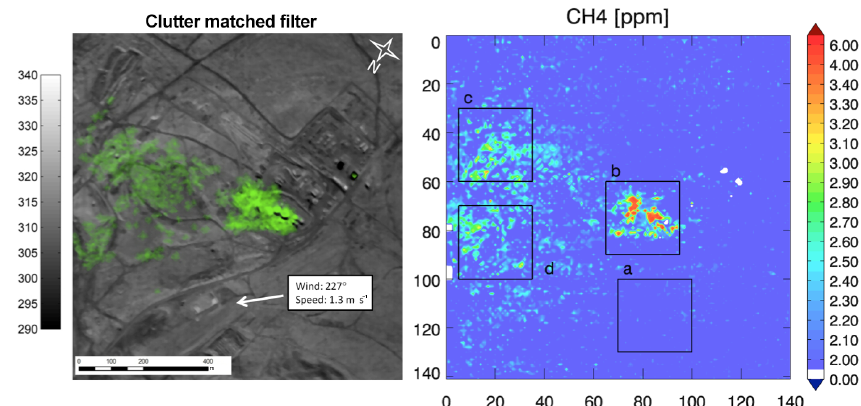
Figure 4. Left: HyTES-detected CH 4 plumes (in green) from oil tanks on 5 February 2015 in Kern County, CA, and overlaid on the grayscale surface temperature image. Right: the CH 4 concentration of the same region from the retrieval estimation. White pixels are bad data and are set to be zero. The arrow on the CMF image is showing a wind direction of 227 ◦ to the north with a 10min average speed of 1.3ms − 1 .